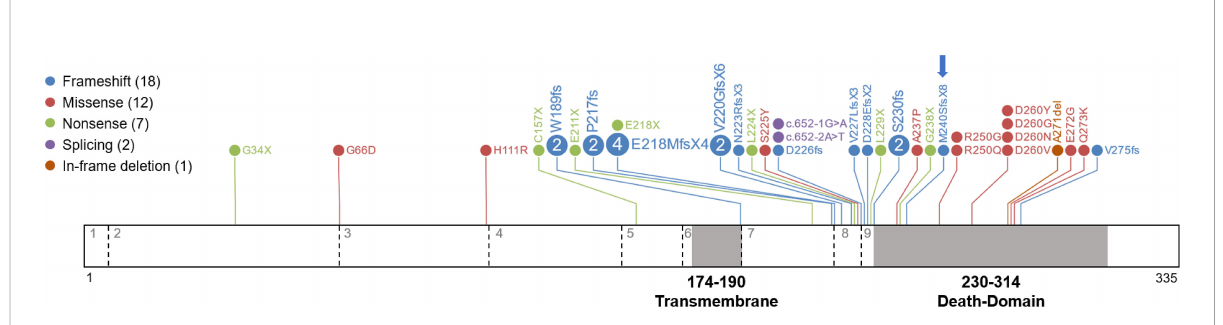
FIGURE 4 Somatic variants reported in ALPS patients. A diagram of the FAS protein is shown with the locations of somatic variants. Exons are separated by dashed lines and indicated with grey numbers. The transmembrane and death domains of the protein are highlighted in grey and amino acid numbers are indicated. Details of all variants are shown in Table